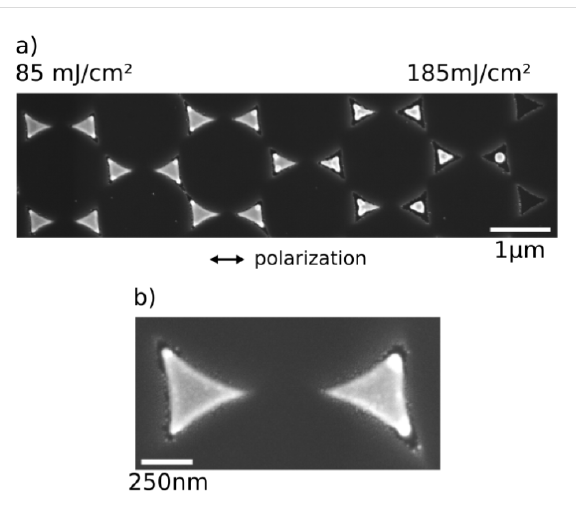
Figure 15: (a) SEM micrograph of colloid lithography nanotriangles irradiated with a 300 ps laser pulse (wavelength: 800 nm) with high gradient to show all typical states of the melting process in one image. The local fluence increases to the right from 85 to 185 mJ/cm 2 . (b) Detail from (a). The scale bars are 1 µm and 250 nm, respectively, the polarization of the incident light is horizontal.